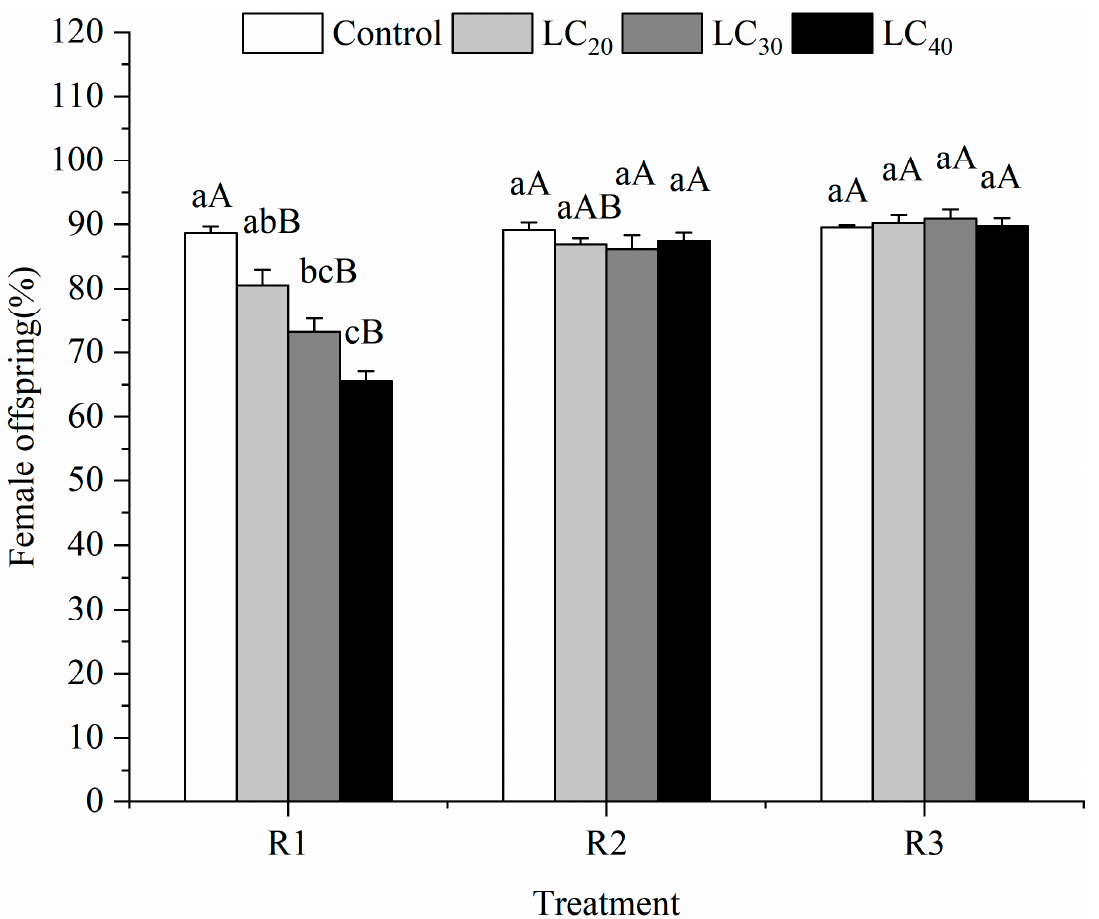
Figure 2. The offspring female ratio (mean ± SE) of Tetrastichus howardi at different concentrations of indoxacarb was treated with three methods. R1 (Routes of exposure 1) is adult exposure to pesticide residues on the glass tube, the LC 20 , LC 30 , LC 40 , and water control were used. R2 (Routes of exposure 2) is adult exposure to pesticide residues on the host, the LC 20 , LC 30 , LC 40 , and water control were used. R3 (Routes of exposure 3) is larval exposure to pesticides through host exposure, the LC 20 , LC 30 , LC 40 , and water control were used. Means in the same routes of exposure followed by different lowercase letters represent a significant difference in different concentrations of pesticide on T. howardi. Means in the same concentrations followed by the same uppercase letter were not significantly different in different routes of exposure based on Tukey’s multiple range test at 5% level.